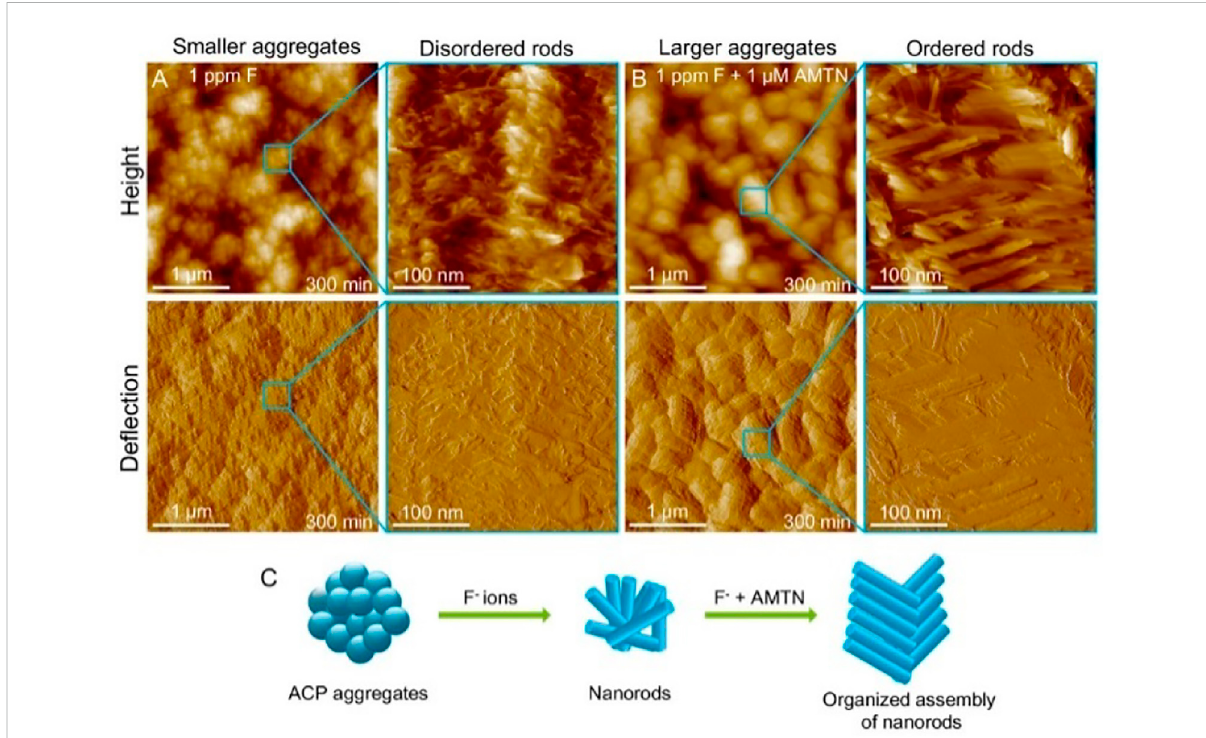
FIGURE 2 AFM height and de fl ection images of NPF solution in the presence of (A) 1 ppm F and (B) 1 ppm F and 1 μ M AMTN for 300 min. (C) Schematic representation of nanorod tissue assembly in the presence of F ions and AMTN. Reprinted with permission from [ (Yu et al., 2019) ]. Copyright © 2019 American Chemical